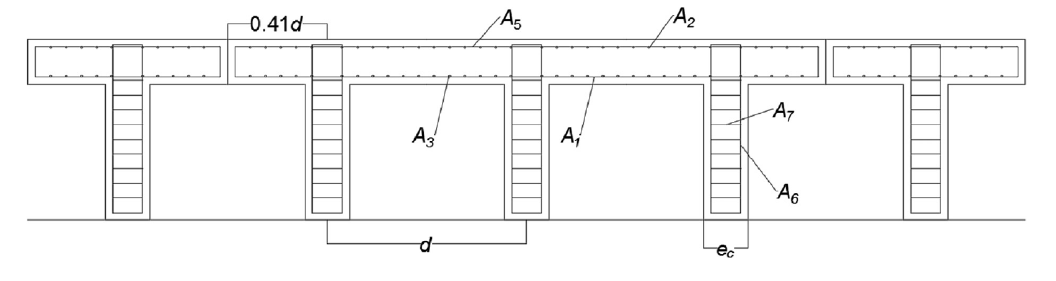
Figure 2. Reinforcement variables for the design of earth-retaining walls. Source: [67].